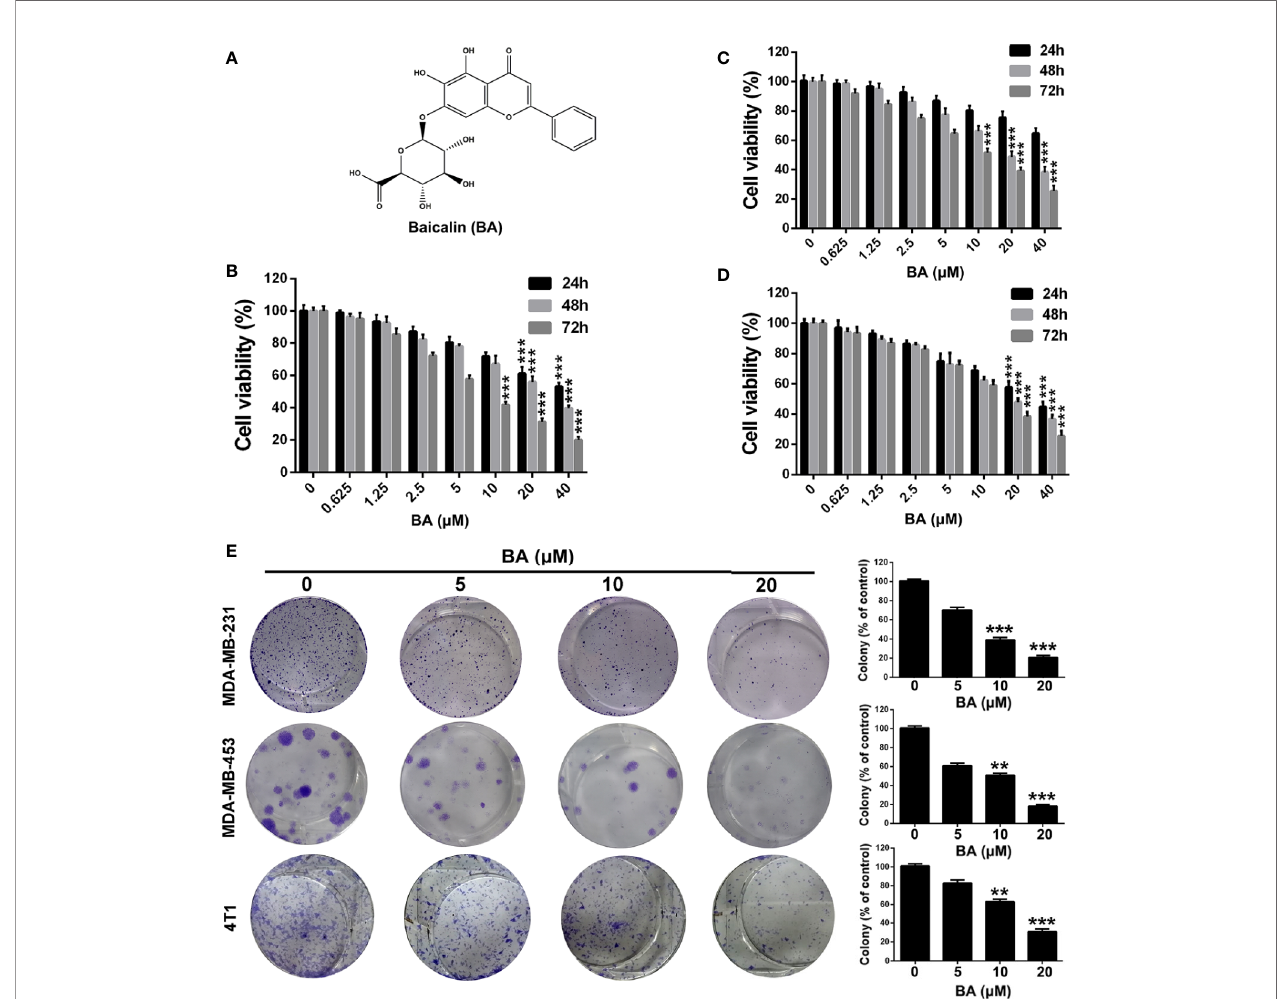
FIGURE 1 | BA exhibited cytotoxicity on breast cancer cells. (A) Chemical structure of BA. (B – D) Viabilities of MDA-MB-231, MDA-MB-453, and 4T1 cells were measured by MTT assay after treatment with different concentrations (0, 0.625, 1.25, 2.5, 5, 10, 20 and 40 m M) of BA for 24, 48, and 72 h. (E) Proliferation of MDA- MB-231, MDA-MB-453, and 4T1 cells were evaluated by colony formation assay after treatment with different concentrations (0, 5, 10, and 20 m M) of BA. Signi fi cant differences are indicated as follows: ** P < 0.01; *** P <